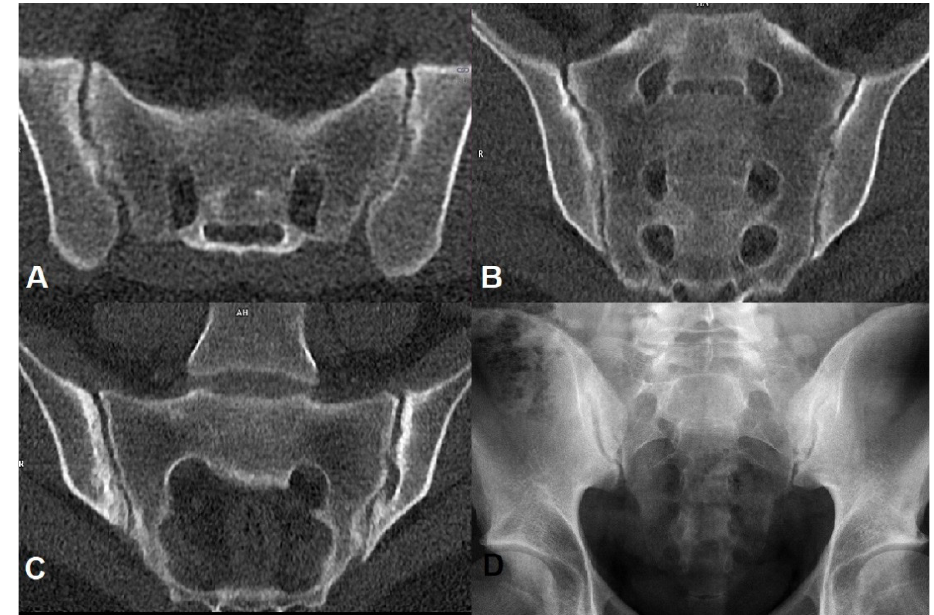
Fig. 1. Man, 29 years old, suffering from long-term low back pain, HLA B27 negative, CRP 10 mg/L, BMI 25. TFULDCT in axial (A), oblique (B), and coronal (C) plane, effective radiation dose 0.12 mSv. In all pictures are seen small usurations, the joint cavities are irregular, locally widespread and light subchondral sclerosis is present. Any bone bridges are evident. We evaluated this finding as grade two according to the New York criteria. X-ray (D) of pelvis, effective radiation dose 0.25 mSv. Bone changes on SIJ are uncertain, the joint space irregularity is more pronounced on left side, despite the changes are more expressed on right side in the TFULDCT